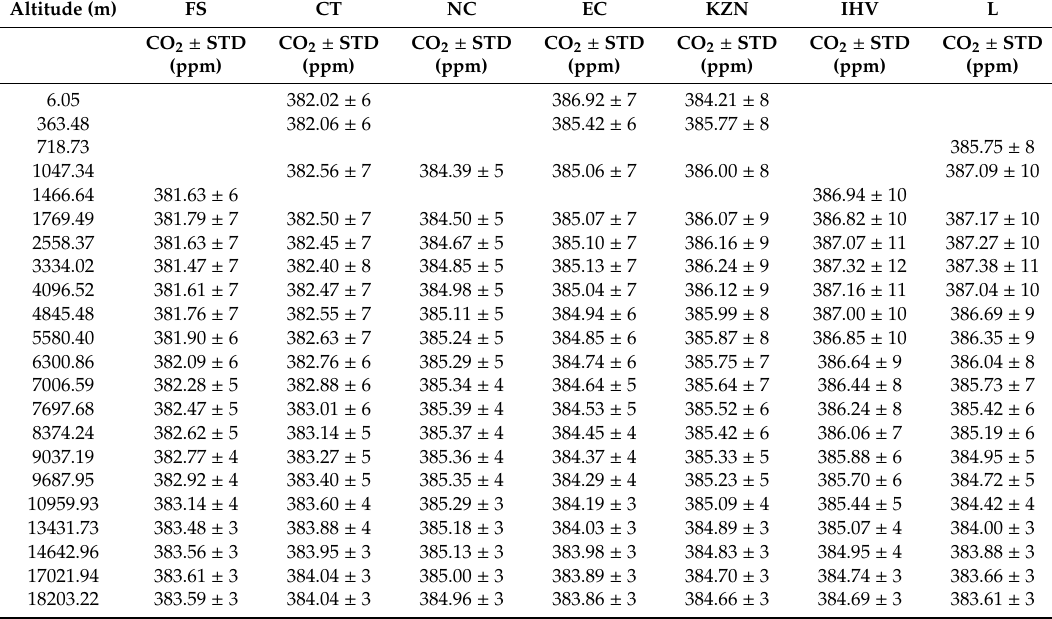
Table A3. Winter (JJA) horizontally averaged CO 2 data and the associated standard deviations at di ff erent altitudes used for vertical profiles at the di ff erent study areas. Altitude